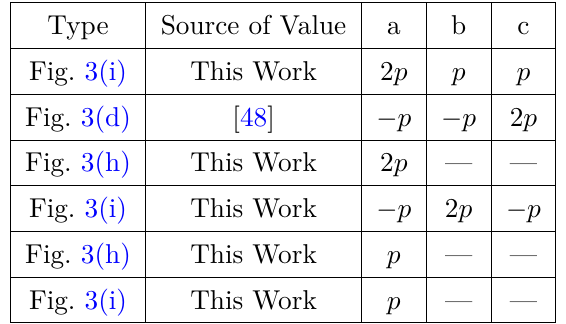
Table 1. The master integrals for this work in the MOM kinematics. For master topologies, see figure